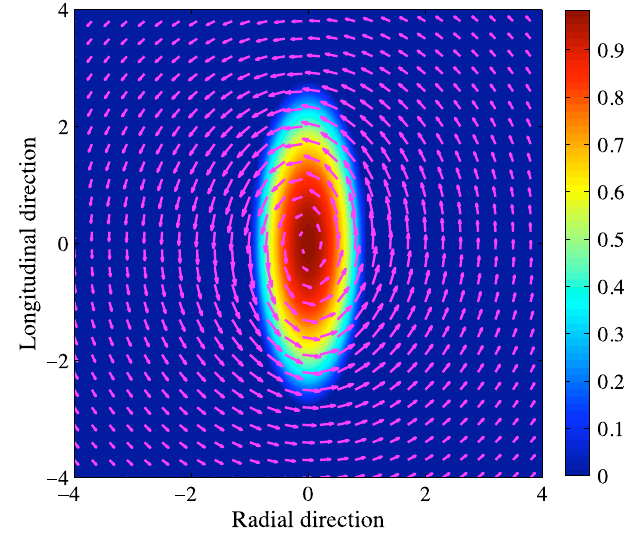
(cid:2) (cid:3) (cid:1) e 0 z (magenta arrows) for an elon-